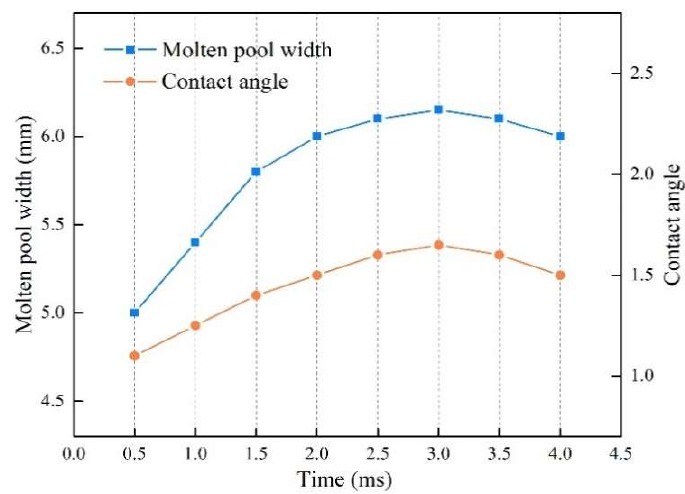
Figure 12. Controlled driving cycle of the molten pool with a welding current of 100 A.